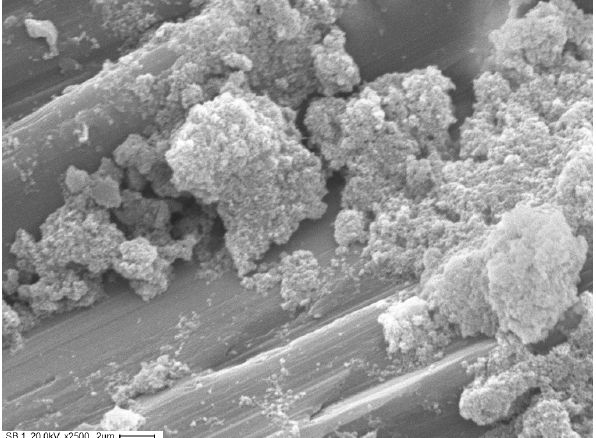
Figure 1. SEM micrograph of fumed silica oxide granules after hydration and calcination at 500 °C with a magnification of ×2500.